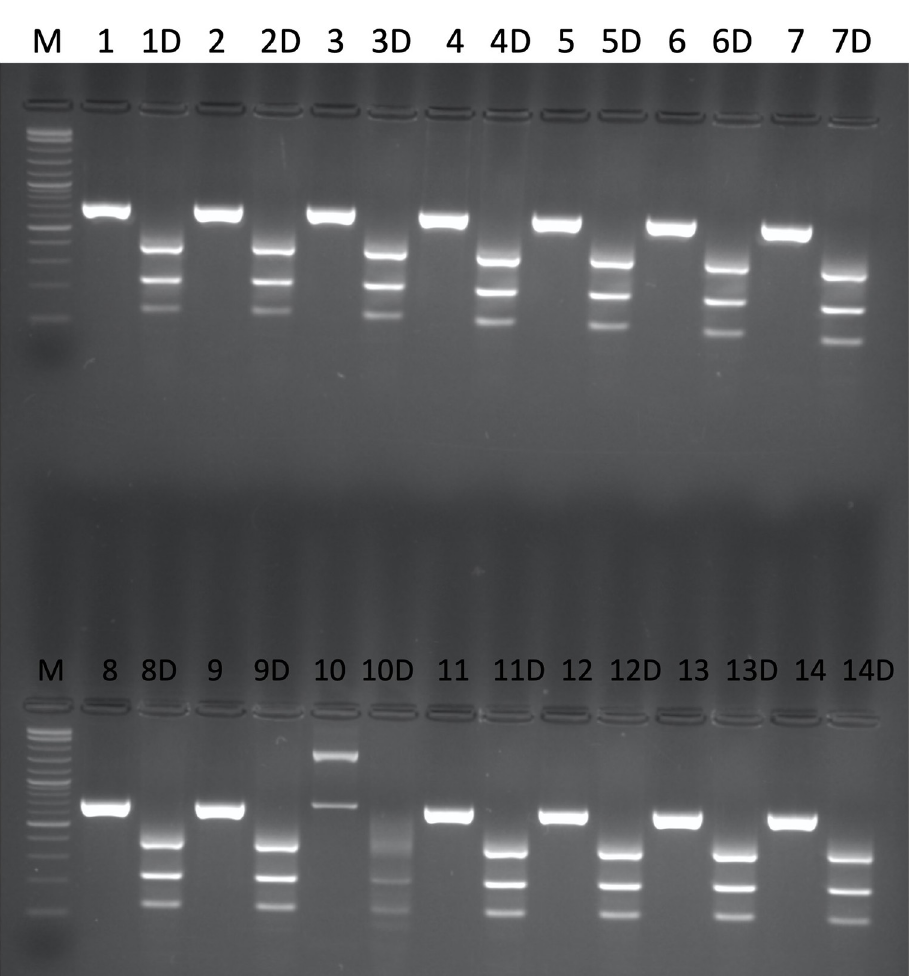
Fig 4. Digestion of 1000 bp downstream 3’ UTR region of HvTLP8 fragment with MwoI in different barley malt and feed varieties (1: Champion, 2: CDC Maverick, 3: CDC Bow, 4: CDC Meredith, 5: CDC Austenson, 6: